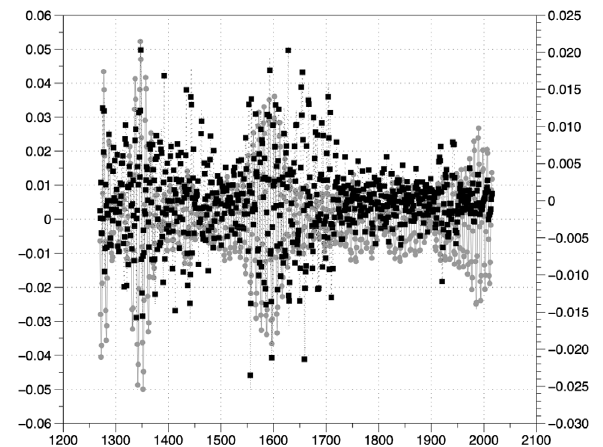
Figure 1. Financial and business cycles dynamics in the UK 1270–2016 (source: authors’